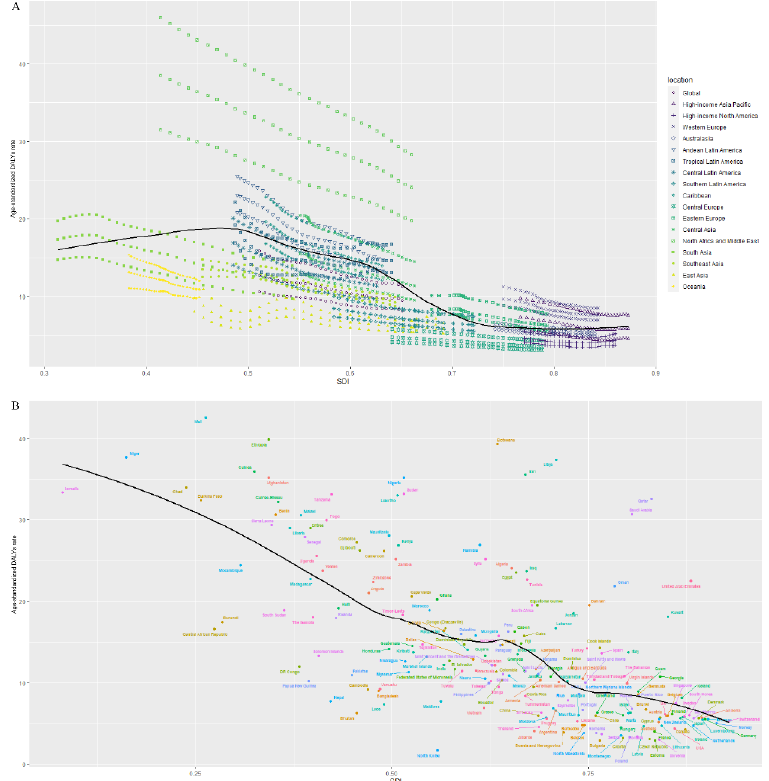
Figure 3. The association between the age-standardized DALY rate and SDI at the regional ( A ) and national ( B ) levels. DALYs: disability-adjusted life-years; SDI: sociodemographic index. 3.4. Trends of Age-Standardized DALY Rates Predicted by BAPC To predict trends in the age-standardized DALY rate by sex in subsequent years,